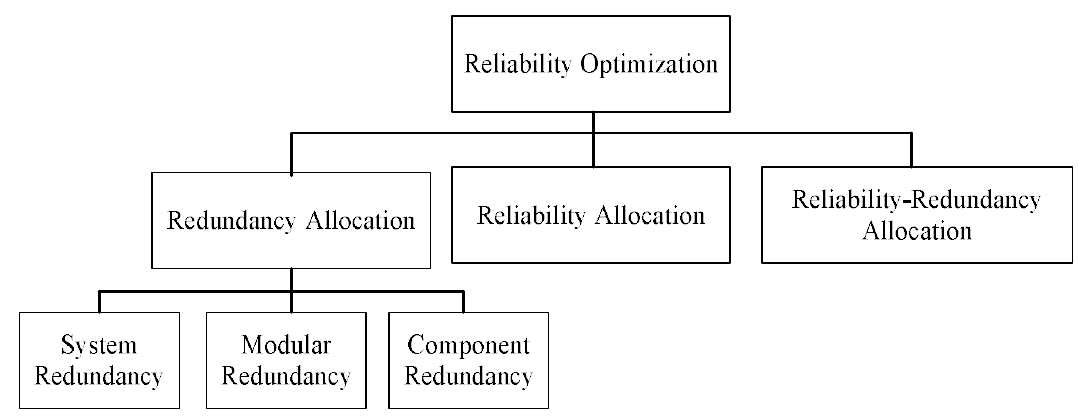
Fig. 1. Reliability optimization problems